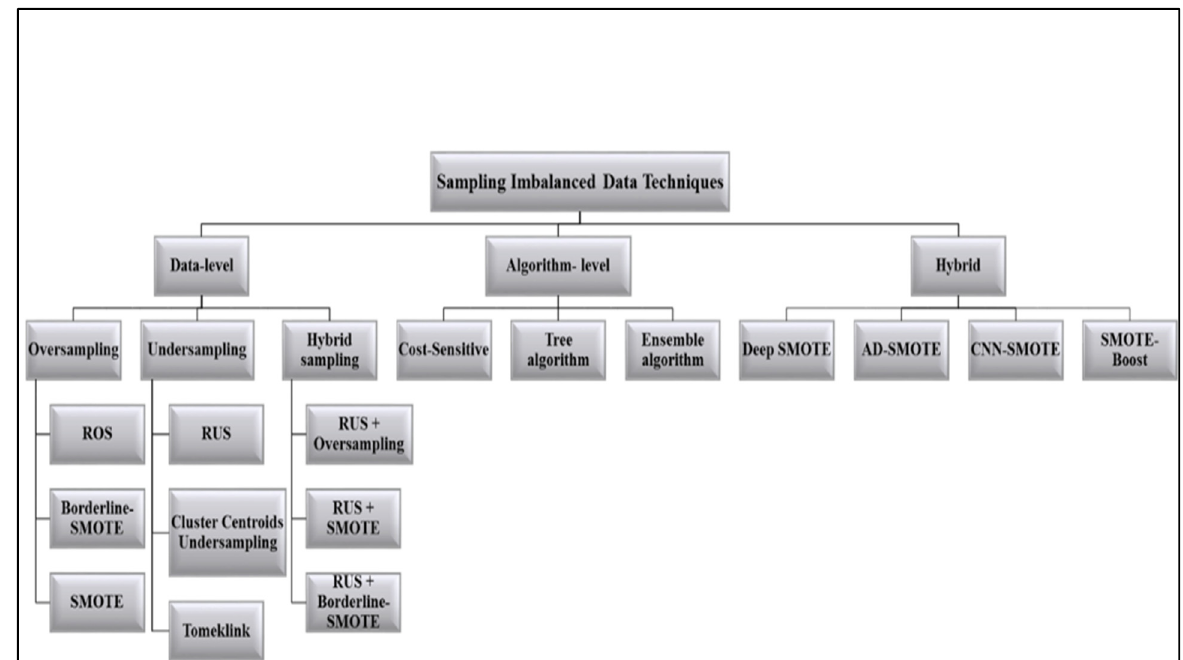
Figure 4. Sampling imbalance data techniques.